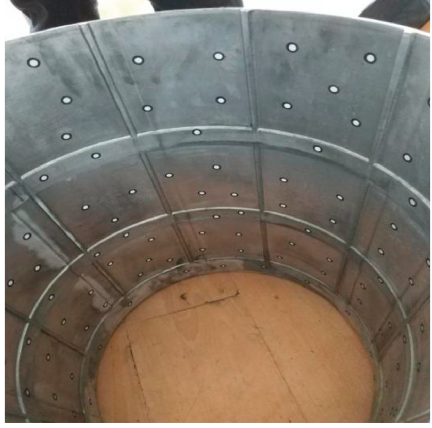
Figure 24: Sample with a rib height of 2.5 mm.